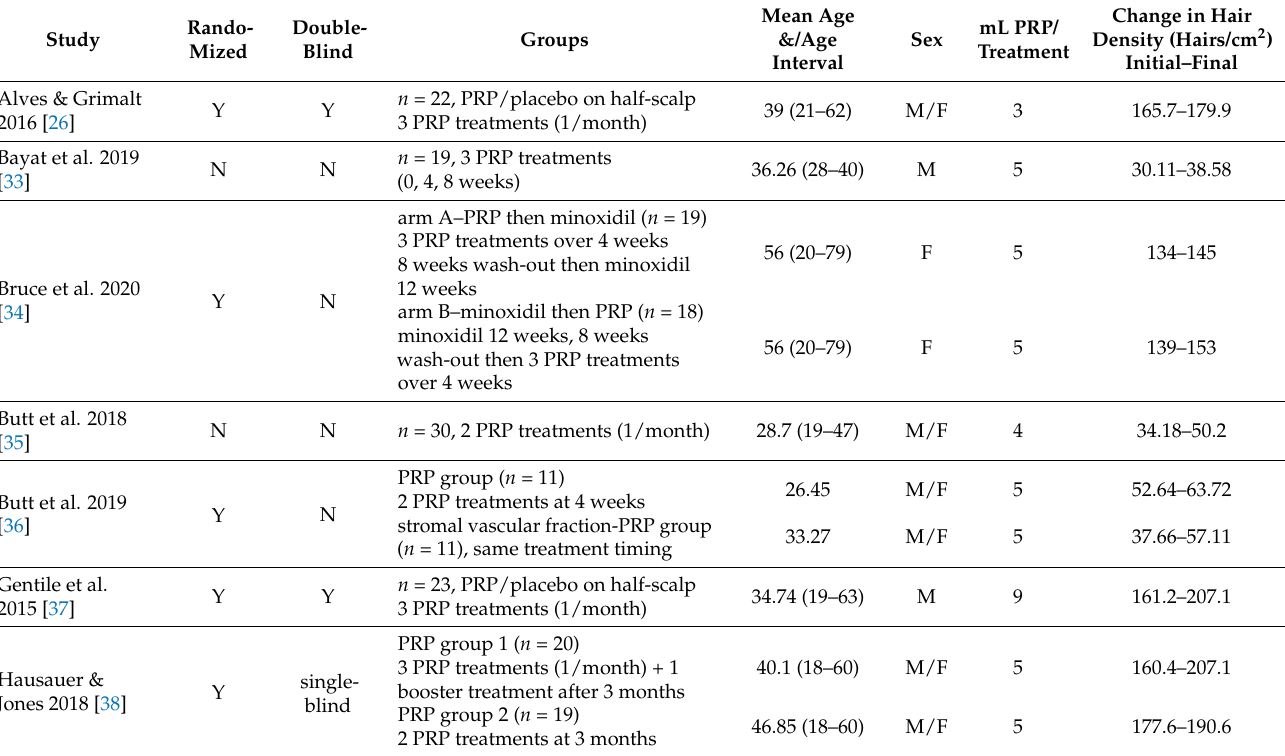
Figure 1. PRISMA flowchart showing the algorithm used for selection of the studies included in the current meta-analysis. Table 1. Features of the clinical trials selected and included in the meta-analysis (in alphabetical order).